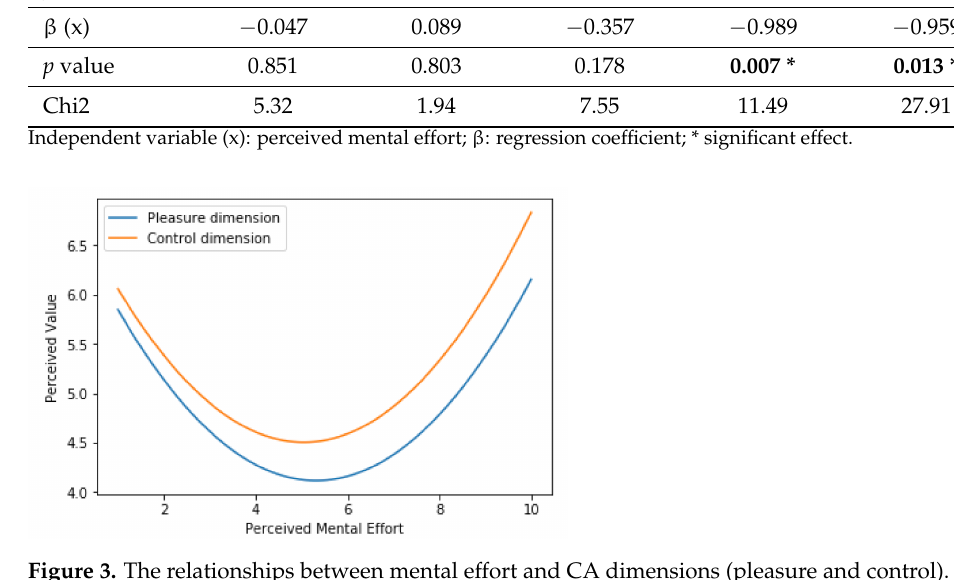
Figure 3. The relationships between mental effort and CA dimensions (pleasure and